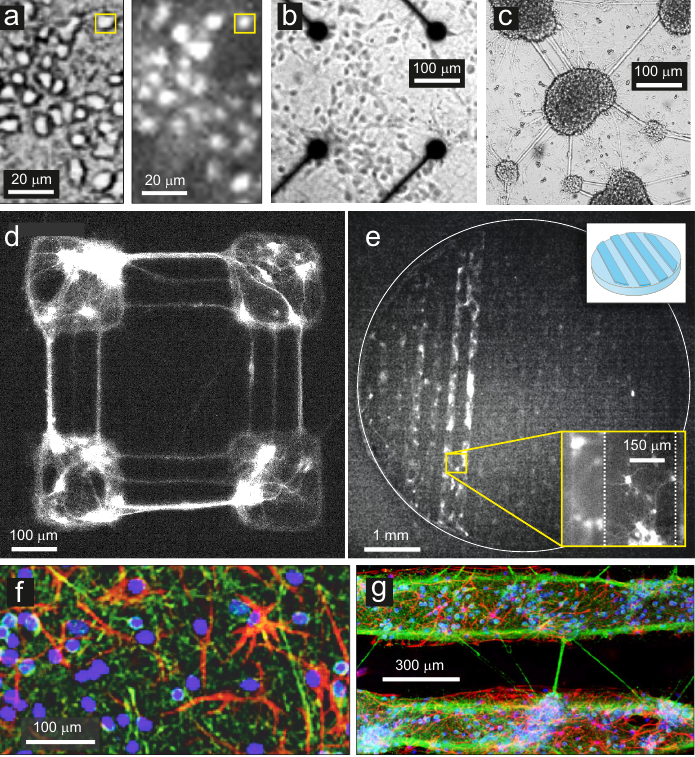
Figure 2. Examples of primary neuronal cultures. ( a ) left, bright field image of neurons grown in a homogeneous manner on a glass substrate. Neurons appear as round objects. Right, corresponding fluorescence image (Fluo-4 recordings), in which neurons appear as bright spots on a dark background. The yellow outline highlights the same neuron in both images; ( b ) bright field image of neurons grown on multielectrode arrays. Neurons appear as gray round objects, and the electrodes as black circles and lines. Each electrode reads the combined electrical signal of several neurons, making direct analyses at cellular resolution difficult; ( c ) bright field image of an aggregated neuronal culture, in which neurons form compact islands about 100 µ m in diameter connected to one another with bundles of axons (straight lines); ( d ) fluorescence image (Cal-520 recordings) of an engineered neuronal culture in which neurons grow only in small squared modules of 200 µ m lateral size. The connectivity between modules is achieved through thin corridors that only allow the pass of axons. In the example shown, each module pair is connected by three corridors, shaping a modular yet strongly integrated network; ( e ) fluorescence image (GCaMP6s recordings) of an engineered neuronal culture in which neurons grow on a topographical pattern (top-right sketch) made by periodic tracks 300 µ m wide and 70 µ m high separated by 300 µ m (bottom-right inset, the white dotted lines indicate the boundaries between tracks). This topographical culture is characterized by a rich dynamics in which activity encompasses different areas of the culture or its entireness. For the example shown, two tracks towards the left of the culture activate while the rest is silent; ( f ) immunostaining in hiPSC-derived cultures to reveal the neuronal nuclei of mature cells (blue), glia (red), and neuronal connections (green); ( g ) equivalent immunostaining for rat primary cultures grown on a topographical pattern (as in panel ( e ) ). Several connections follow the edges of the